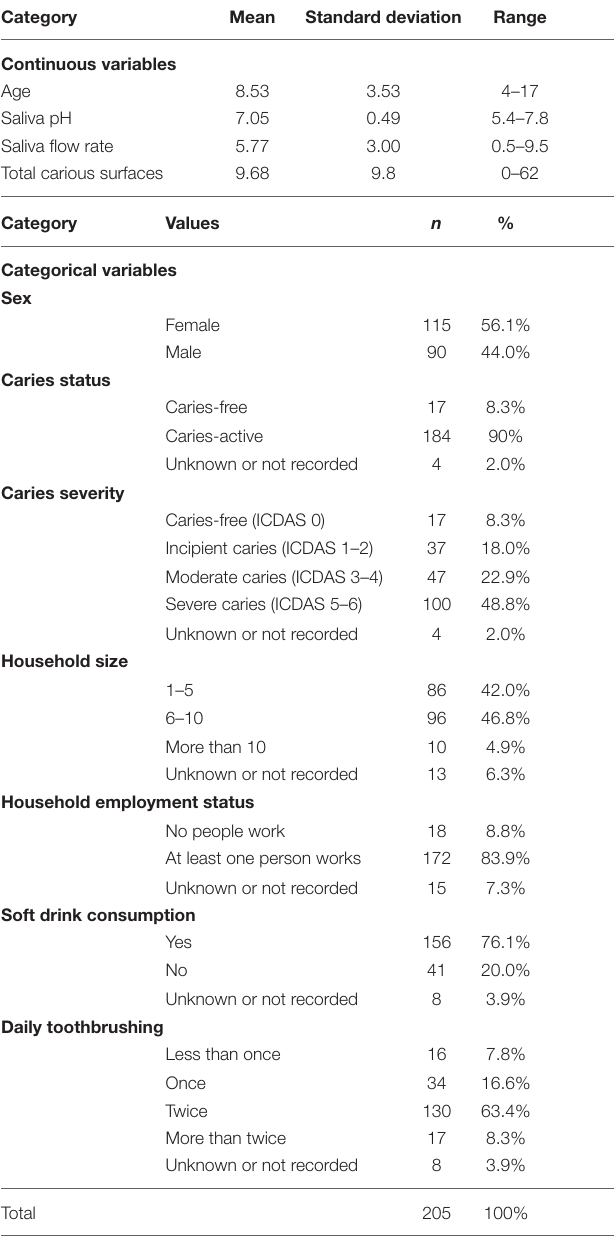
TABLE 1 | Sociodemographic characteristics of study participants.